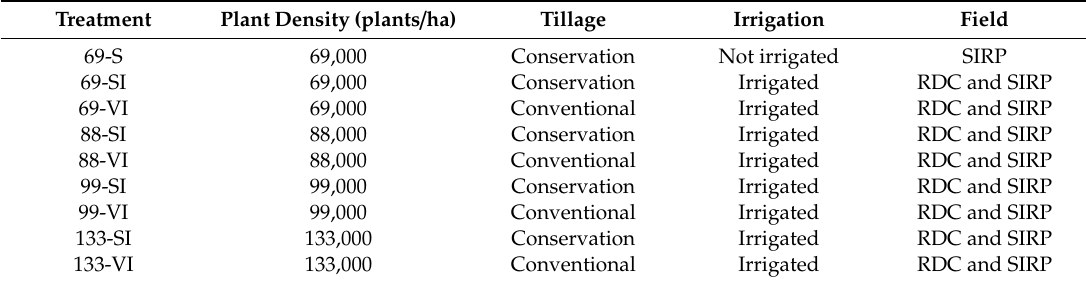
Table 1. Plant density and tillage method treatments applied in RDC and SIRP fields.